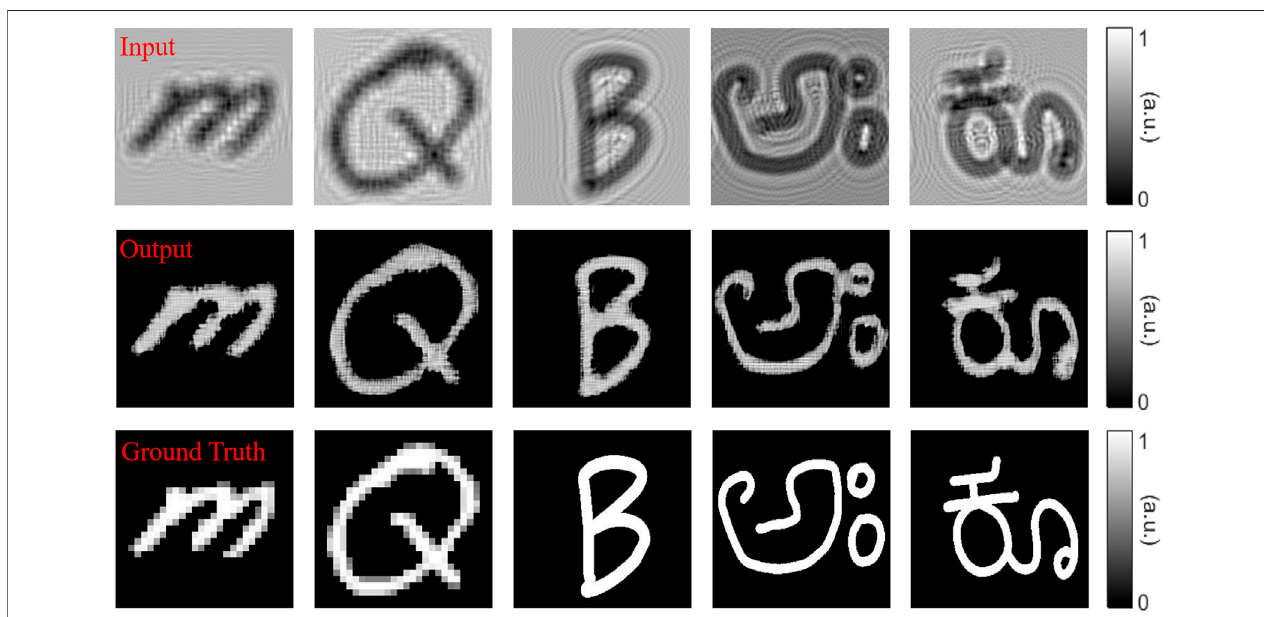
FIGURE 6 | Generalization evaluation of the proposed unsupervised PhysNet-AH method with different datasets. The fi rst row shows the diffracted acoustic fi eld intensitiesfrom differentdatasetsat z=10 mm. Thesecondrowshows thecorrespondingreconstruction resultsfrom theabovementionedacoustic fi elds.Thelast row shows the target images (ground truth) of the two English letters “ m ” and “ Q ” in the MNIST dataset, one English letter B, and two symbols of Kannada in the Chars74K dataset.